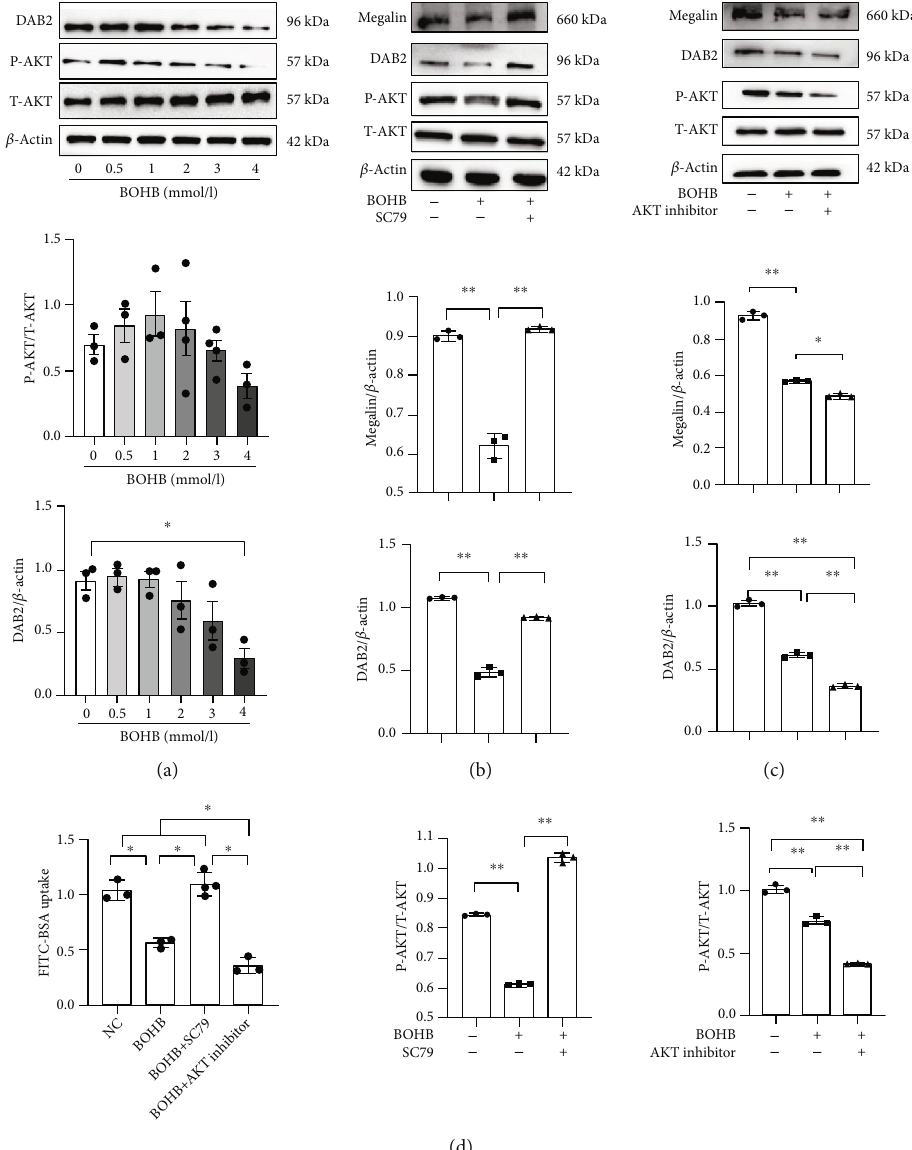
Figure 4: Beta-hydroxybutyrate a ff ects endocytosis of proximal tubule epithelial cells through AKT/DAB2/megalin signaling pathway. (a) DAB2, P-AKT, and T-AKT in indicated concentrations of BOHB. (b) Megalin, DAB2, P-AKT, and T-AKT in indicated concentrations of BOHB with SC79 or not. (c) Megalin, DAB2, P-AKT, and T-AKT in indicated concentrations of BOHB with AKT inhibitor or not. (d) FITC-BSA uptake level in HK2 cells. BOHB, beta-hydroxybutyric acid; NC, normal control; SC79, AKT activator. Data are expressed as mean ± SD . ∗∗ Represents P < 0 : 01 ; ∗ represents P < 0 : 05